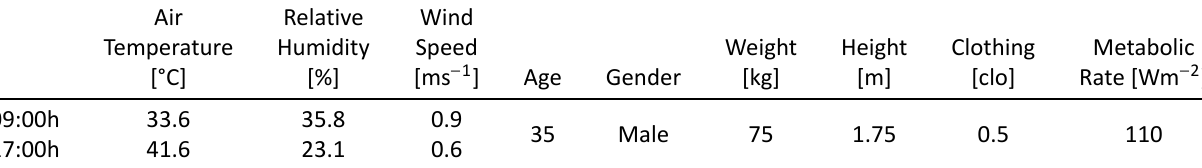
Table 1. Meteorological data for August 7, 2016, and personal characteristics used as input for thermal comfort modeling.